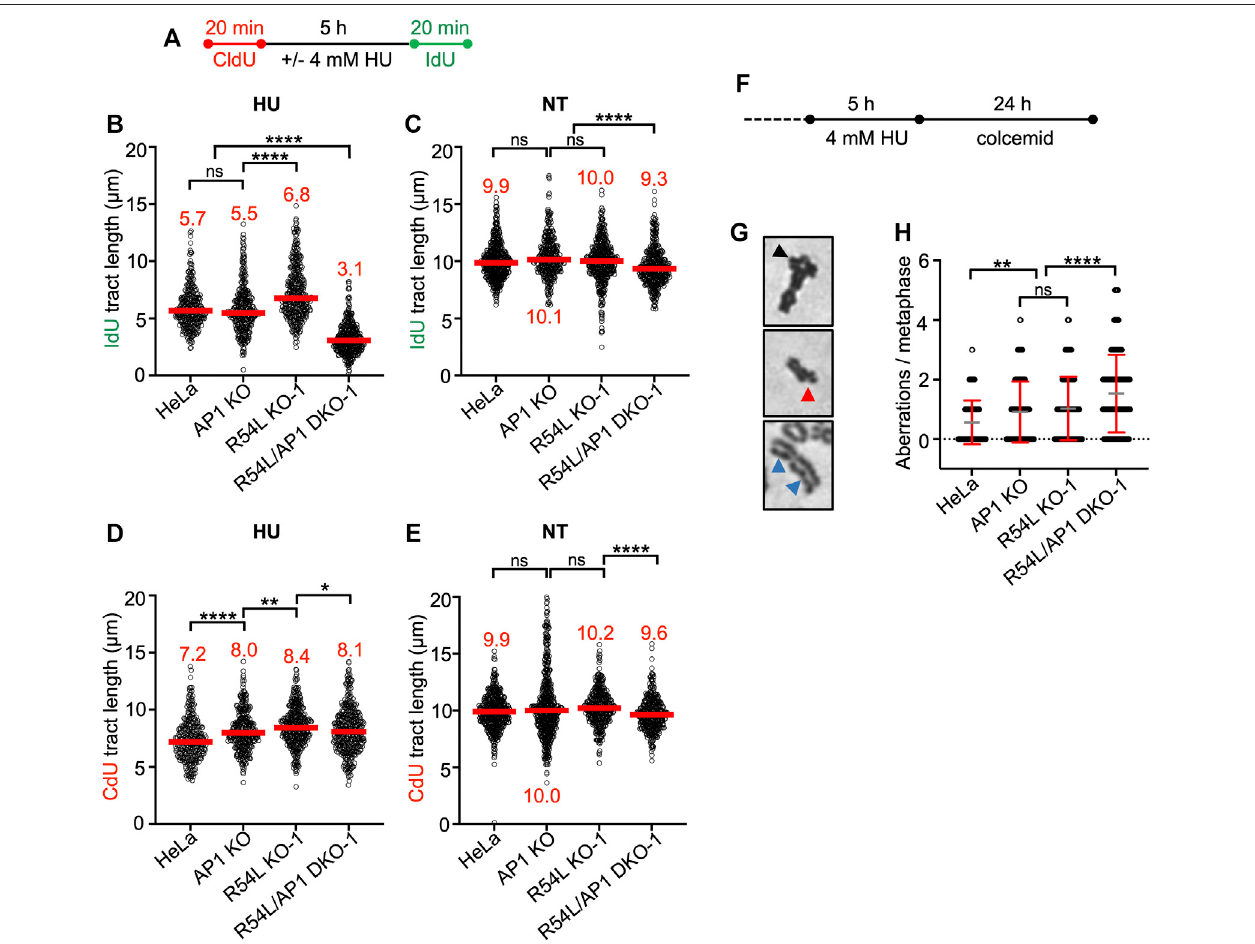
FIGURE3| Concomitantlossof RAD51AP1 and RAD54L resultsinincreasedreplicationstressandgenomeinstability. (A) Schematicoftheexperimentalprotocol fortheDNA fi berassay. (B) MedianIdUtractlength(green)afterHUinHeLa,AP1KO,R54LKO-1,andR54L/AP1DKO-1cells.Datapointsarefrom100to150 fi bersof three independent experiments each,withmedians inred. (C) MedianIdU tract length(green) underunperturbed conditions(NT).Datapoints arefrom100to150 fi bers ofthreeindependentexperimentseach,withmediansinred. (D) MedianCldUtractlength(red)afterHUinHeLa,AP1KO,R54LKO-1,andR54L/AP1DKO-1cells. Data points are from 100 to 150 fi bers of three independent experiments each, with medians in red. (E) Median CdU tract length (green) under unperturbed conditions (NT). Data points are from 100 to 150 fi bers of three independent experiments each, with medians in red. *, p < 0.05; **, p < 0.01; ****, p < 0.0001; ns, non-signi fi cant; Kruskal-Wallis test followed by Dunn ’ s multiple comparisons test. (F) Schematic of the experimental protocol to induce chromosomal aberrations. (G) Representative micrographs ofchromosomal aberrations after HU; radial (black arrow head), chromatid break(redarrow head)and chromatid gaps (blue arrow heads). (H)